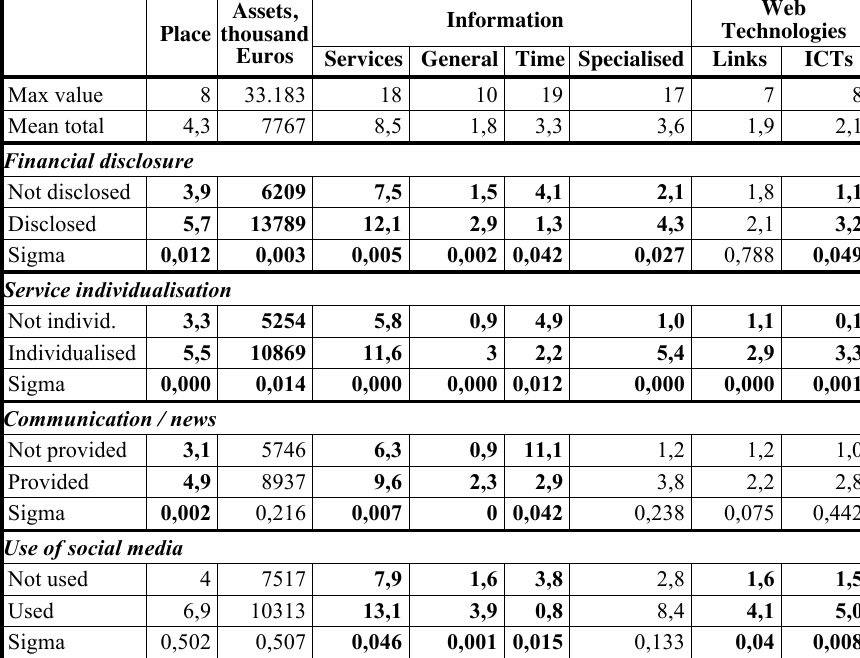
Table 6. Mean values and test of significant difference in groups by financial disclosure, service individualization, communication, and use of social media Assets, Place thousand Euros